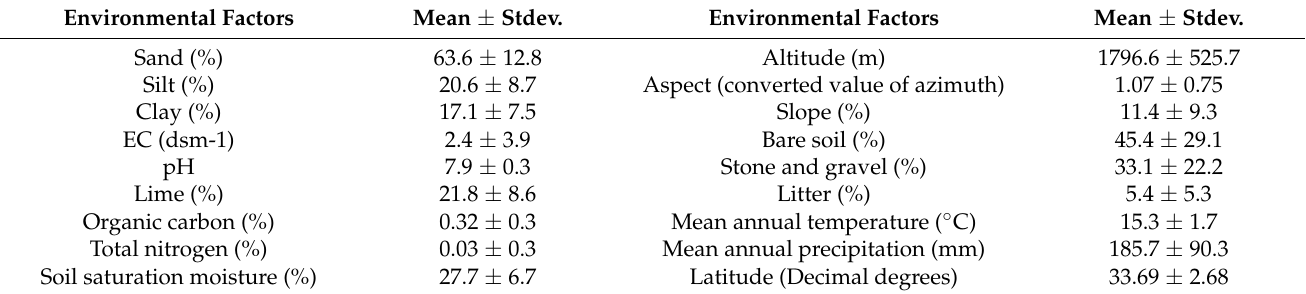
Table 1. The average values of the environmental factors in the A. sieberi habitats.